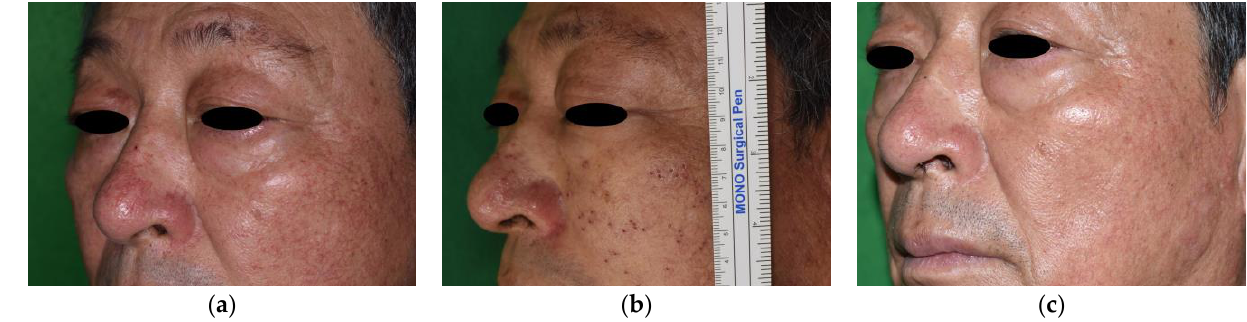
Figure 3. Facial telangiectasia in a 68-year-old man. ( a ) Telangiectasia on nasal dorsum, left cheek before treatment. ( b ) Multiple deep holes were made in line with the course of the telangiectasia. ( c ) The telangiectasia showed improvement on left cheek, but traces of lesion left on nasal dorsum were observed at 3-month follow-up. Table 2. Change in the size of the lesion after CO 2 laser treatment.